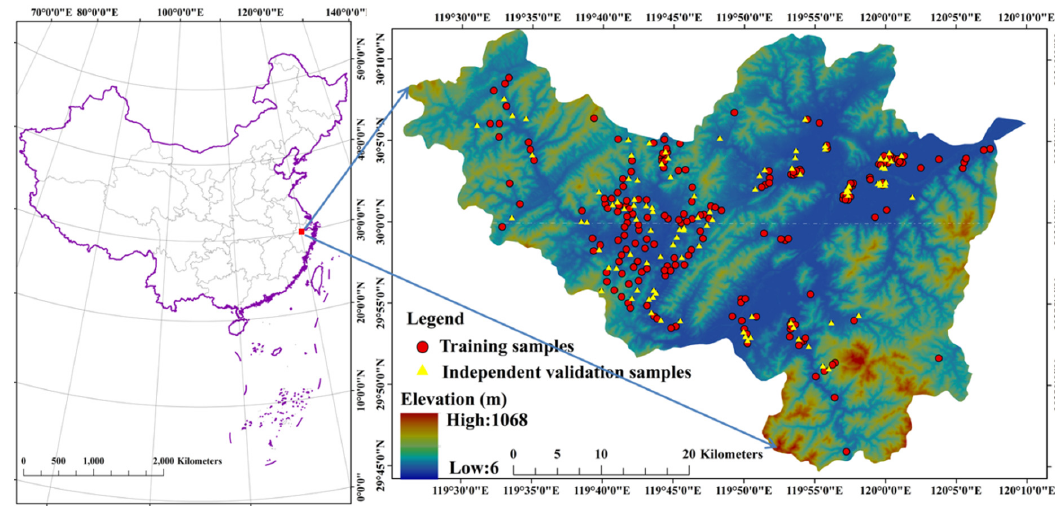
Figure 1. Study area and sampling locations.